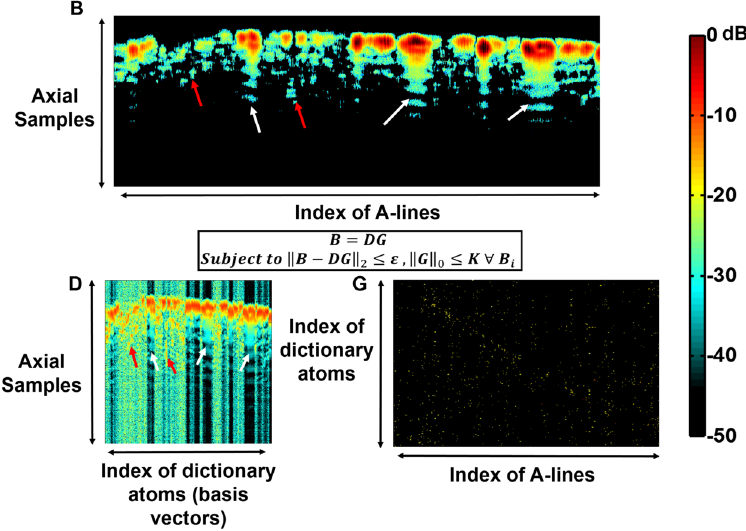
Figure 3. Decomposition of the raw B-scan ( B ) into Dictionary ( D ) and Coefficient ( G ) matrices. Note that G is sparse and contains very few significant